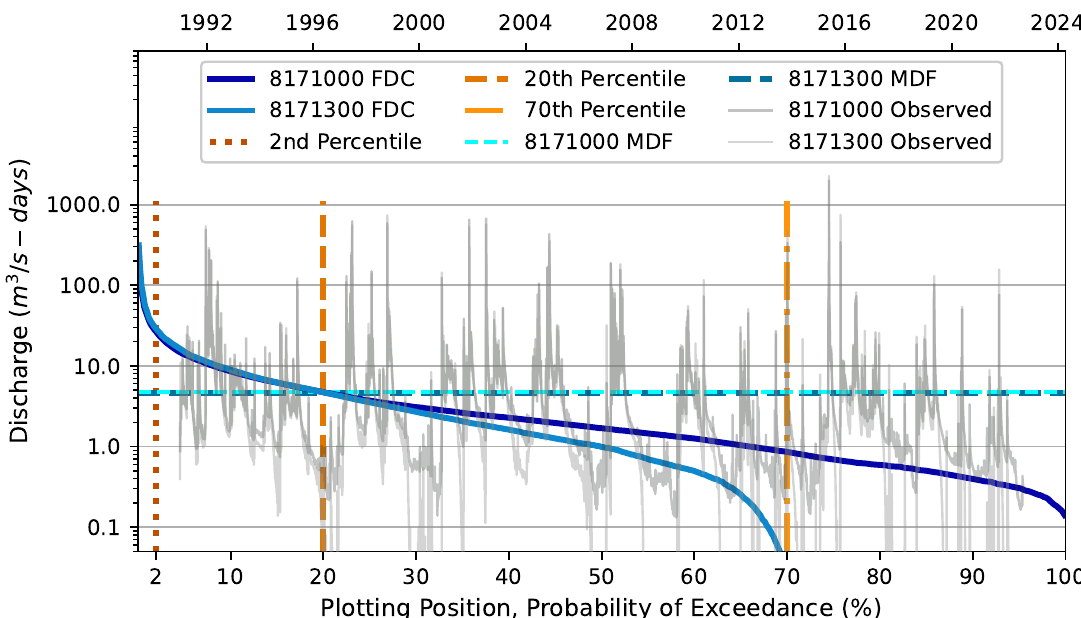
Plotting Position, Probability of Exceedance (%) Figure 3. Flow duration curves (FDCs) for two Blanco River gauging stations on opposite ends of the BFZ Edwards Aquifer Recharge Zone: 8171300 is at the downstream edge of the Recharge Zone, and 8171000 is at the upstream edge. The low flow threshold for this study is the mean daily flow (MDF) in Table 2, and MDF for these two gauging stations is approximately equal. Note that discharge at 8171300 is generally less than discharge at 8171000 for values less than the